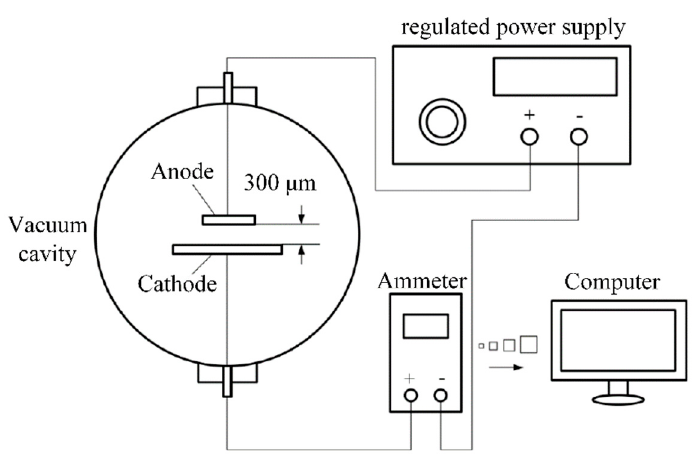
Figure 4. The schematic diagram of the electrodes configuration of field emission measurement.